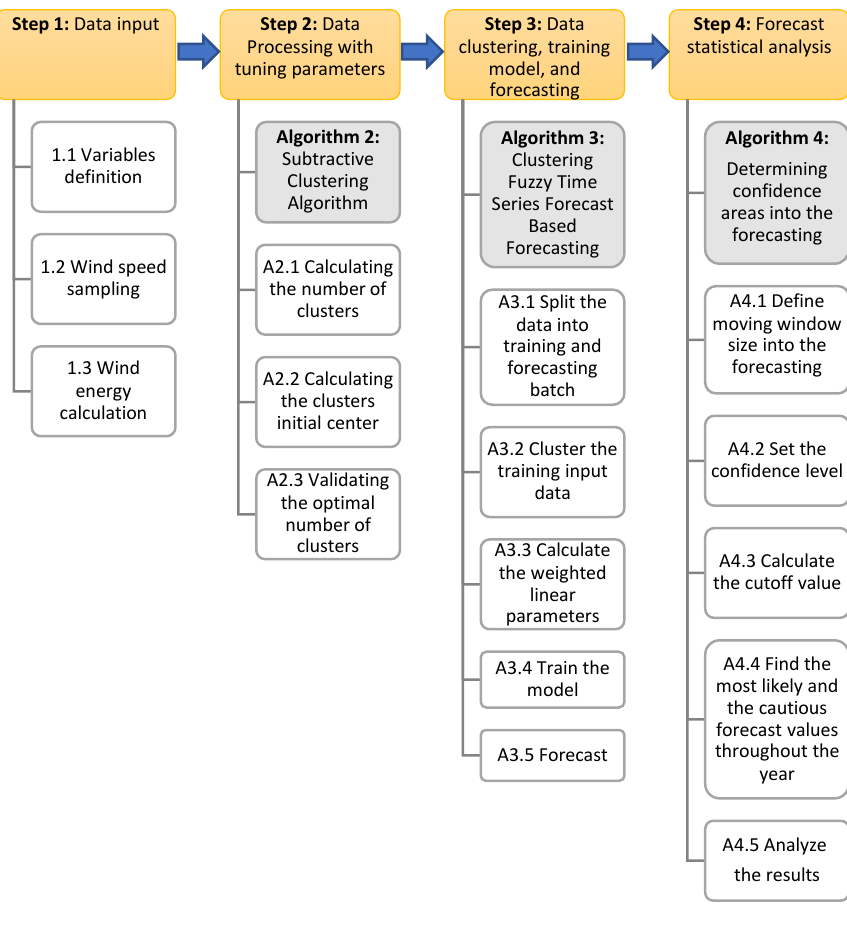
Figure 1. Method